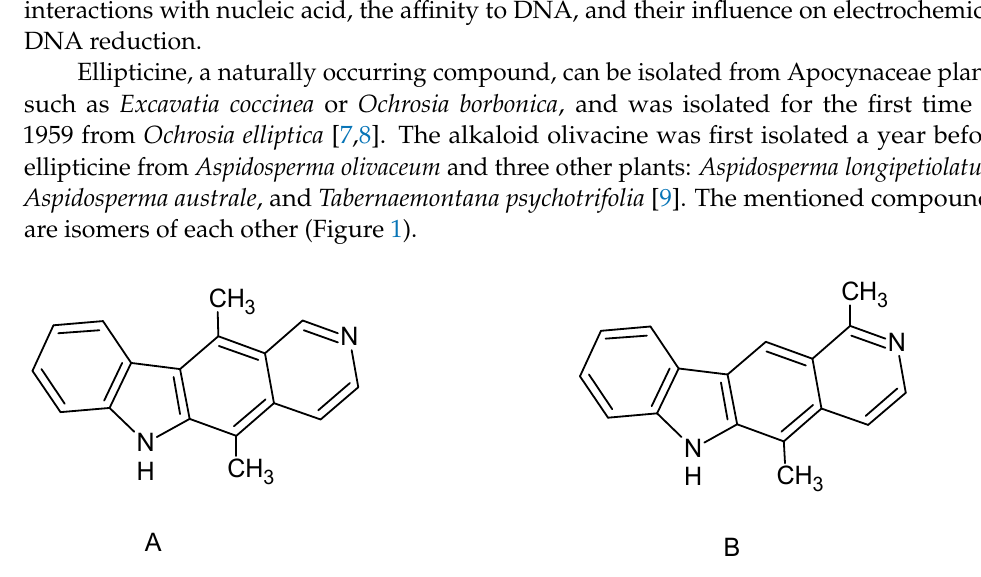
Figure 1. Chemical structures of ( A ) ellipticine (5,11-dimethyl-6 H -pyrido[4,3- b ]carbazole) and ( B ) olivacine (1,5-dimethyl-6 H -pyrido[4,3- b ]carbazole).